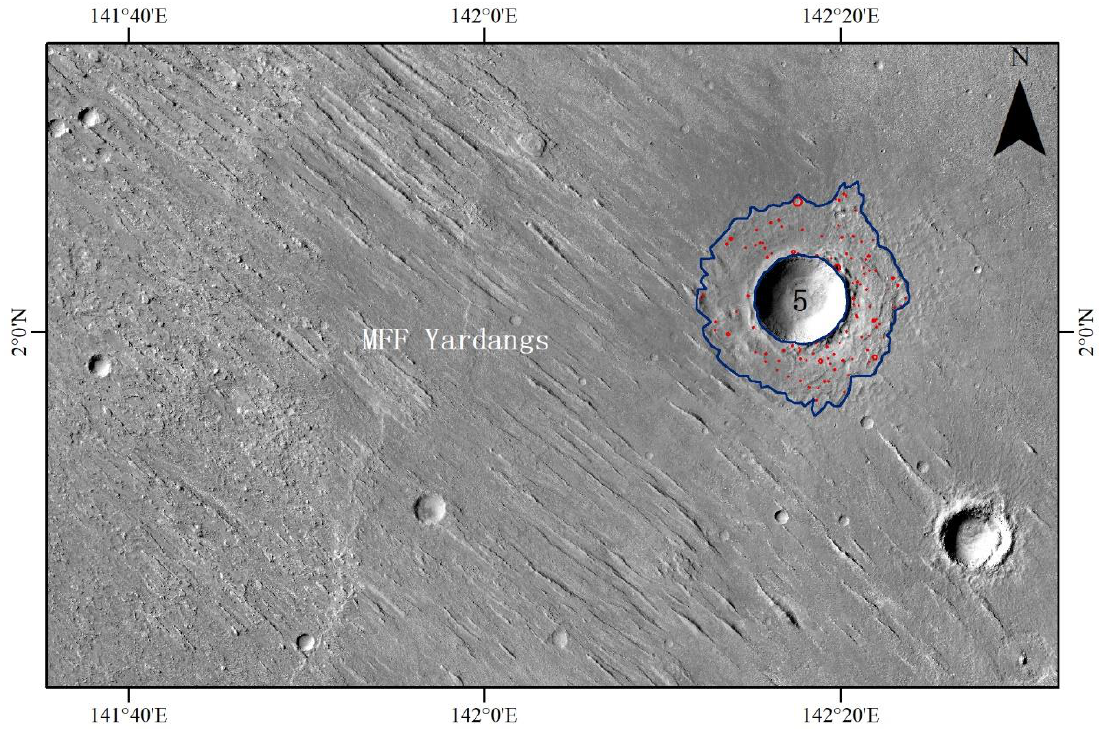
Figure 7. Yardangs’ morphology in the MFF. The yardangs have a long ridge shape, and their peaks are smooth, indicating that these yardangs are in the adolescent or mature stage.